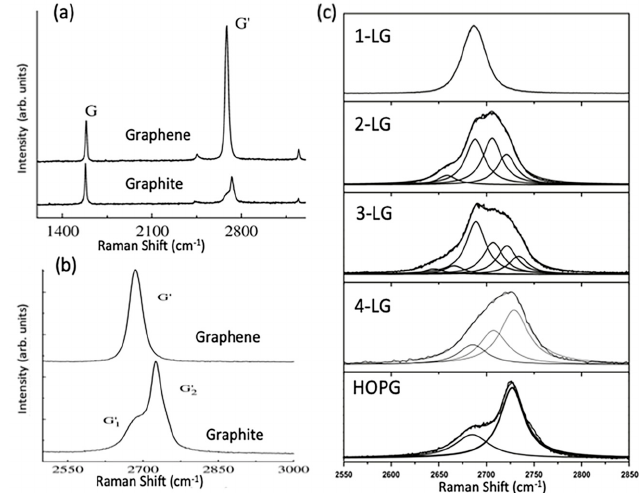
Figure 22. ( a ) comparison of the Raman spectra of graphene and graphite using a 514 nm excitation wavelength. ( b ) a close-up comparison of the 2D peaks in graphene and graphite (reprinted with